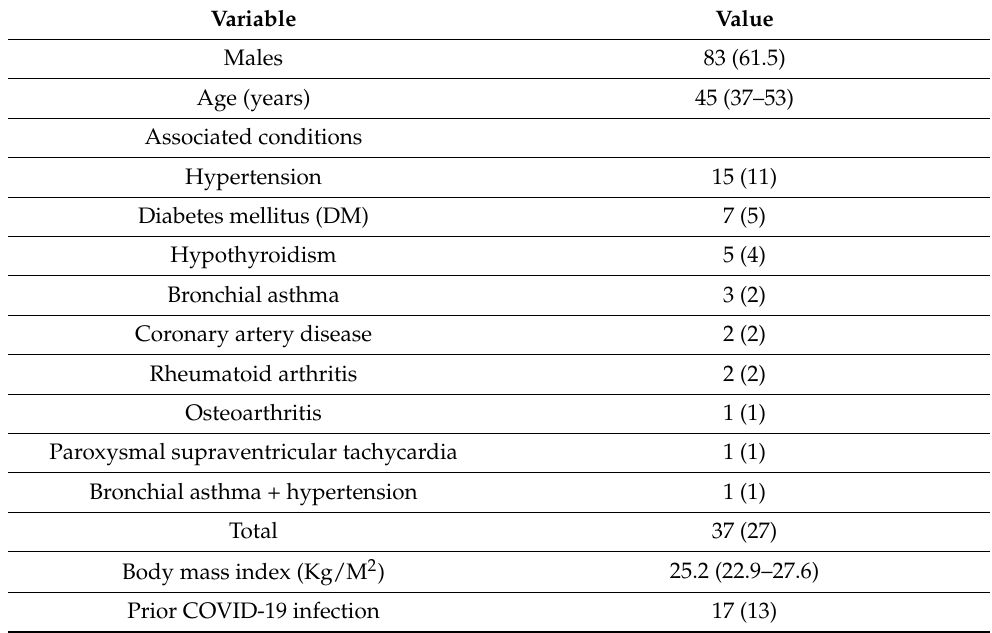
Table 1. Characteristics of the study participants ( n =